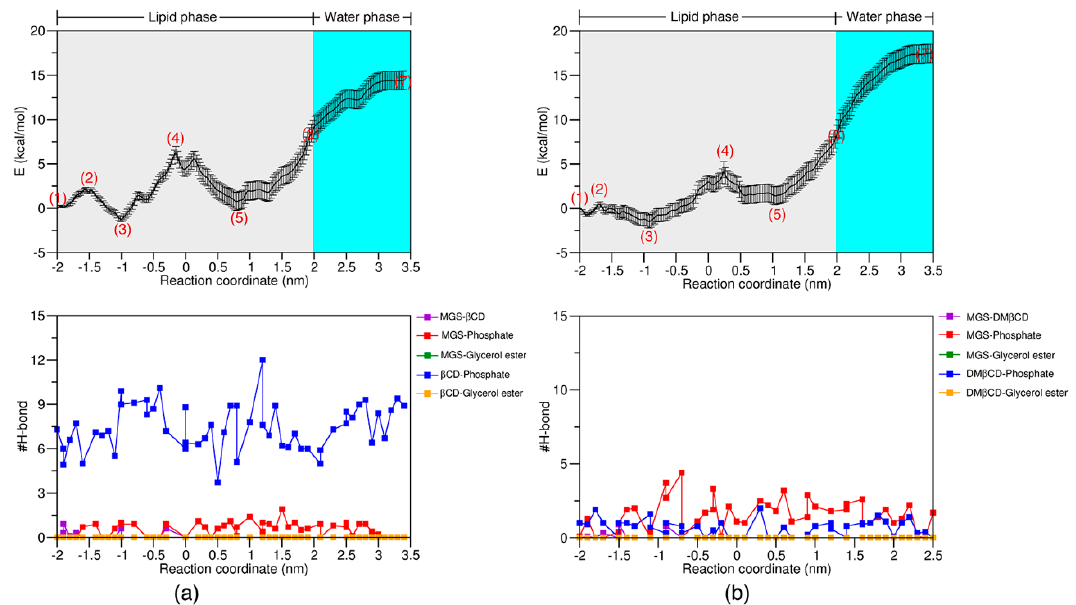
Figure 8. The free energy profile and time evolution of the number of H-bonds for ( a ) A-MGS / β CD and ( b ) A ‐ MGS/DM CD.